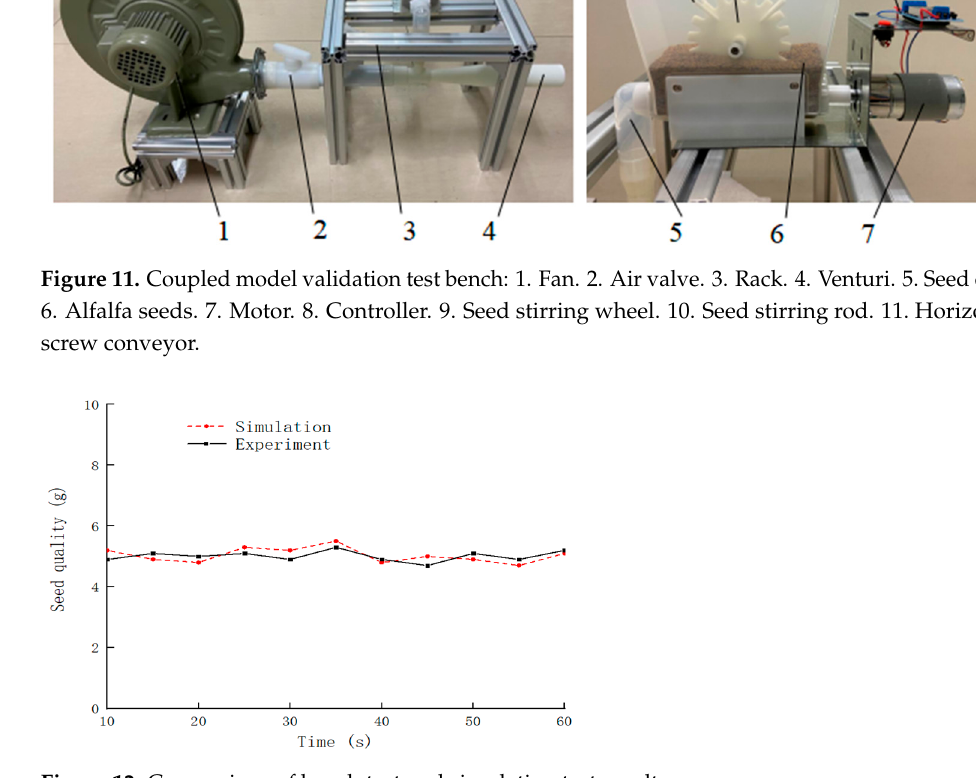
Figure 12. Comparison of bench test and simulation test results.